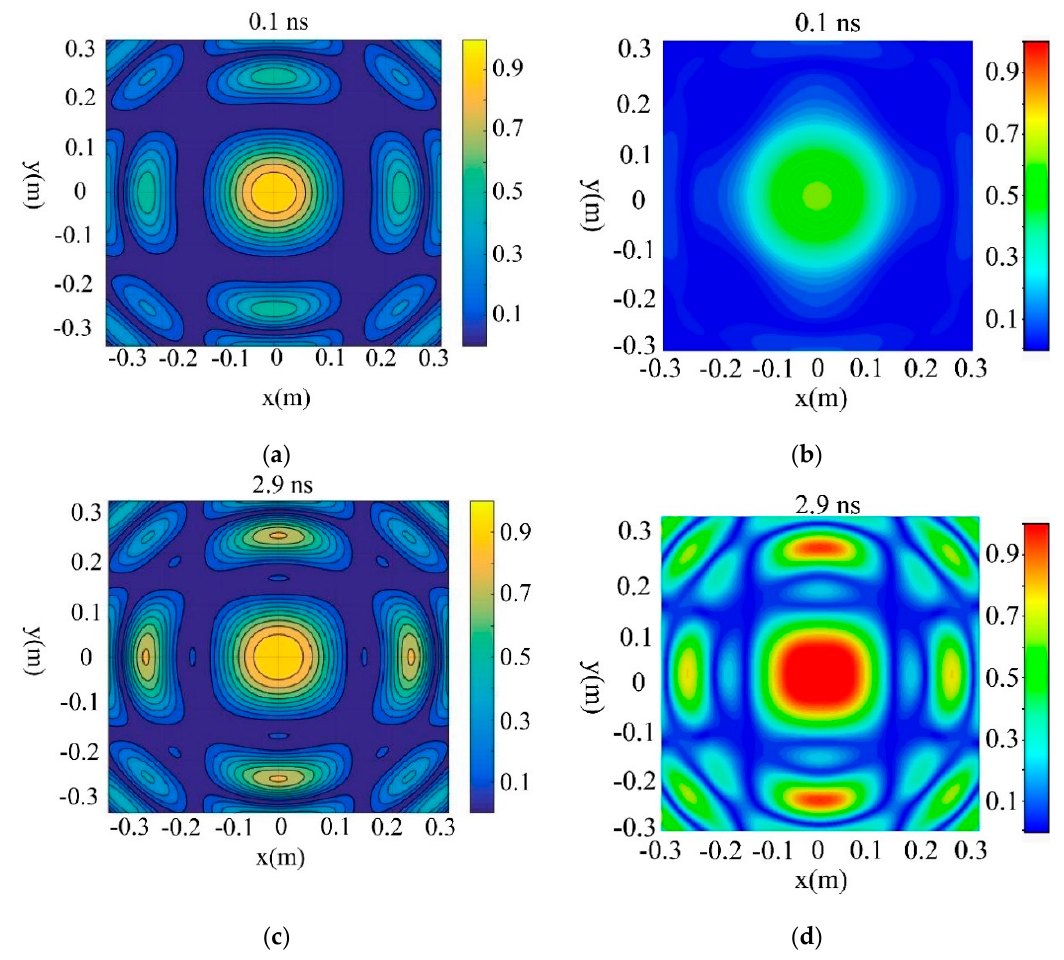
Figure 10. Array focus effect figures with different moments and different methods: ( a ) field distribution at 0.1 ns in the numerical methods after optimization, ( b ) field distribution at 0.1 ns in the full wave simulation after optimization, ( c ) field distribution at 2.9 ns in the numerical methods after optimization and ( d ) field distribution at 2.9 ns in the full-wave simulation after optimization.